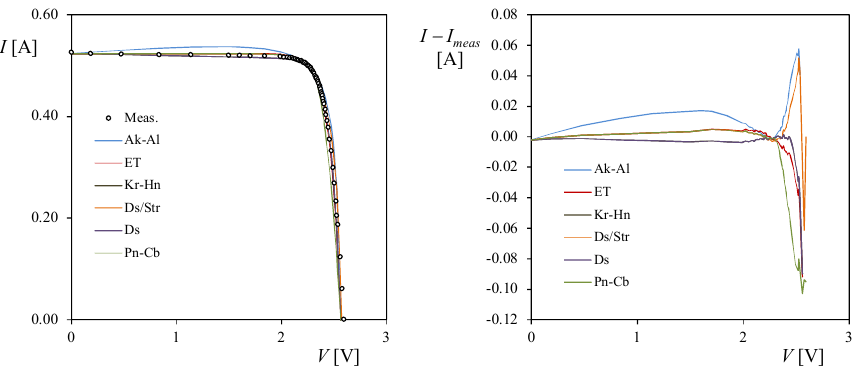
Figure 4. Curves for the explicit models analyzed, fitted to the RTC France solar cell data using the analytical methods proposed; see Section 2 ( left ). The error in relation to the data is also included in the figure ( right ).